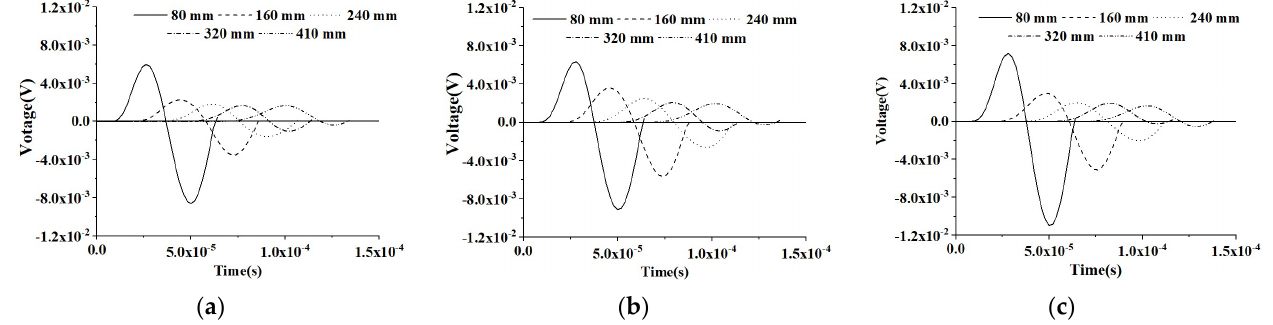
Figure 6. Time-domain response of sensors at different measurement distances from the actuator under a sinusoidal excitation signal for healthy CMFEMs. ( a ) CMFEM 1; ( b ) CMFEM 2; ( c ) CMFEM 3.